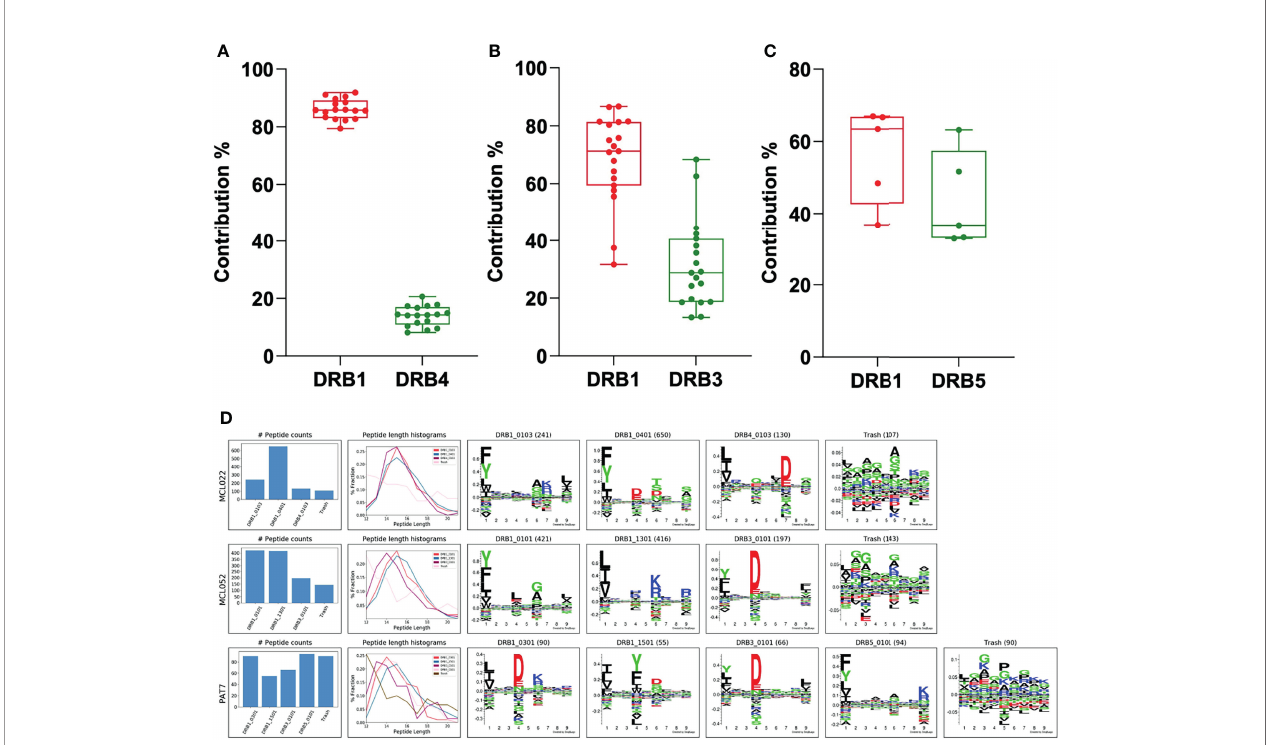
FIGURE 8 | Contribution of the DRB3, 4 and 5 alleles vs. DRB1 in biological samples. (A) Contribution of DRB4 vs. DRB1 was calculated using biological samples from ten patients with mantle cell lymphoma (MCL), one patient with chronic lymphocytic leukemia (CLL), three patients with rheumatoid arthritis (RA) and two patients with Lyme disease (LA). (B) Contribution of DRB3 vs. DRB1 was calculated using samples from nine patients with mantle cell lymphoma (MCL), two patients with chronic lymphocytic leukemia (CLL), one patient with rheumatoid arthritis (RA), four patients with Lyme disease (LA) and one patient with Sarcoidosis. (C) Contribution of DRB5 vs. DRB1 was calculated using samples from two patients with rheumatoid arthritis (RA), two patients with Lyme disease (LA) and one patient with Sarcoidosis. In all cases, the DRB3, 4 or 5 with the highest LD was assigned to the DRB1 before deconvolution of the DR peptidome by the MHCMotifDecon. (D) Peptide counts, length distribution per alleles or trash cluster, and logos from deconvolution of HLA-DR peptidome of the patients after assigning DRB3, 4 and 5 to the associated DRB1 alleles. Each row represents one